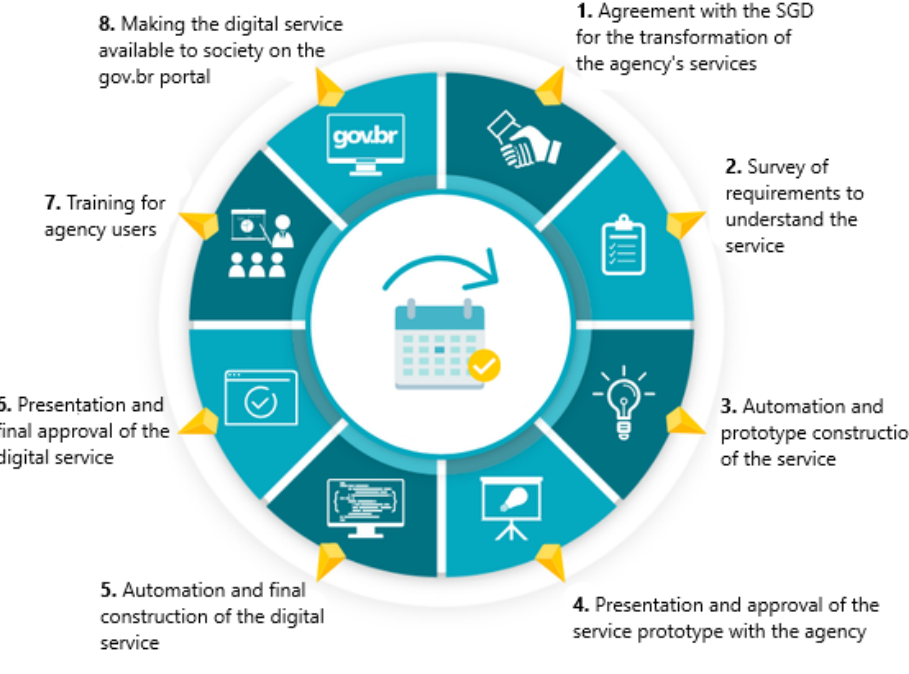
Figure 2. Service automation steps (Adapted from